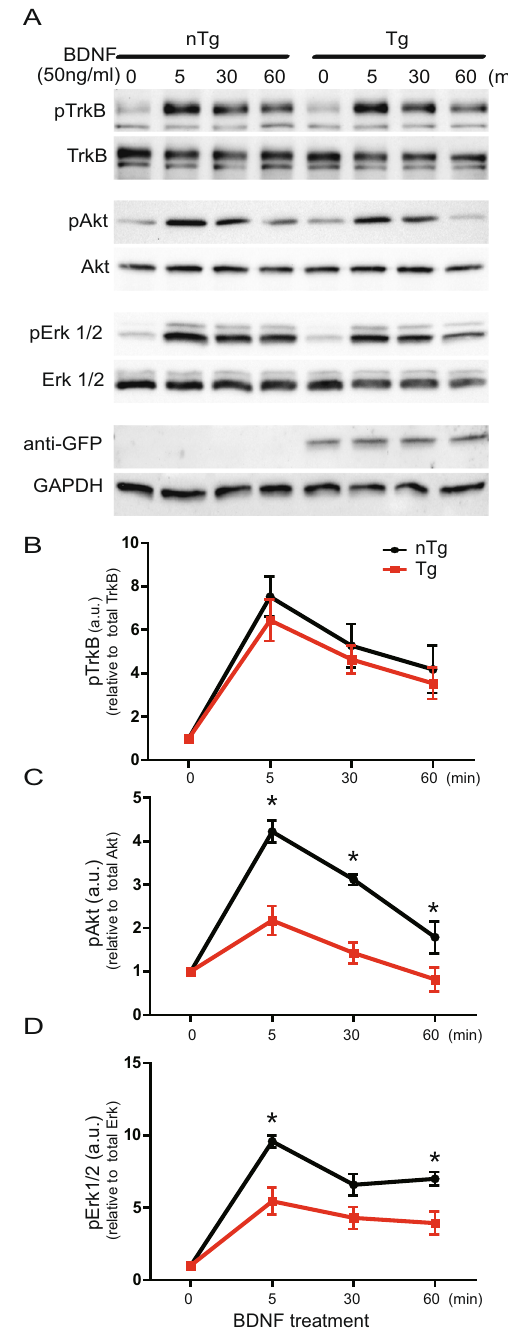
Figure 5. Increased level of ASYN inhibited BDNF/TrkB-mediated down-stream signaling. Mouse E18 cortical neurons were cultured in 12-well plate (mass cultures) and stimulated with 50 ng/ml at DIV4. Equal amounts of protein lysates were analyzed by SDS/PAGE and immunoblotting with specific antibodies as indicated ( A ). Semi- quantitative results are shown for the level of activated TrkB ( B ), activated Akt ( C ) and activated Erk1/2 ( D ). At least three independent experiments were performed for all the studies presented. For these blots, we do not have all original full size, uncut blots. Nevertheless, the original blots are presented in Supplemental